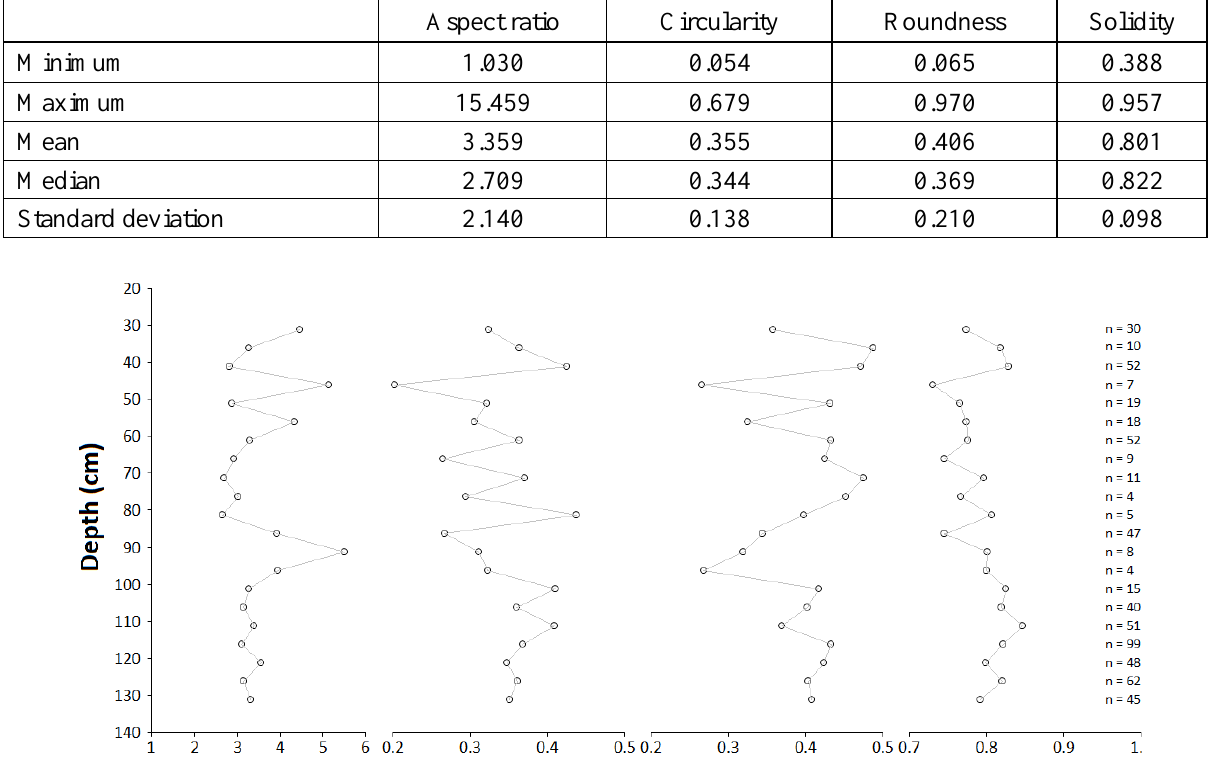
Table 2. Descriptive statistics for shape descriptors.